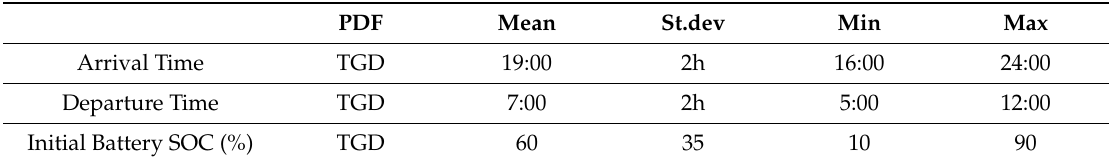
Table 1. Modified probability distribution of an electric vehicle (EV)’s driving pattern, adapted from [39].